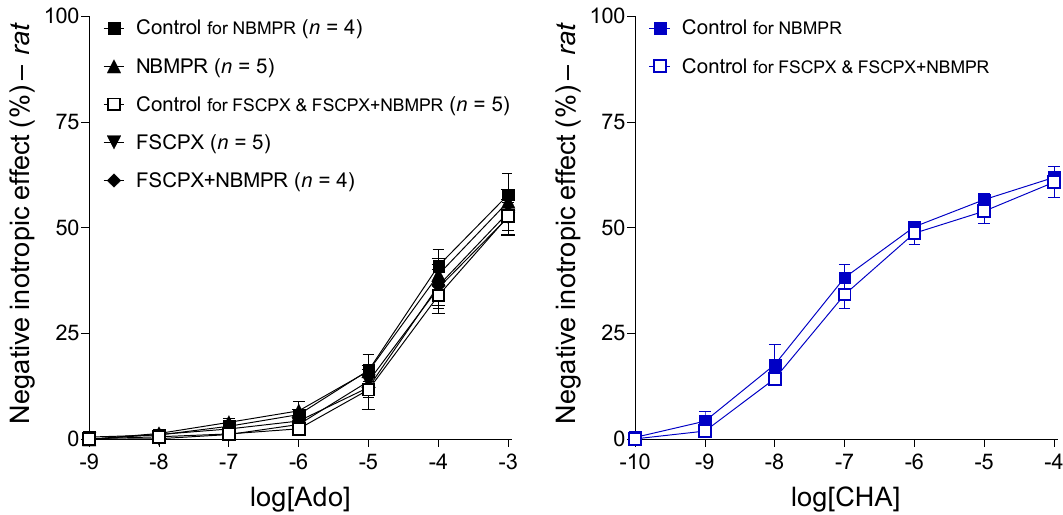
Figure 3. The direct negative inotropic effect of adenosine ( left panel ) and CHA ( right panel ) in the isolated rat left atrium, in the absence of any chemicals affecting the adenosinergic homeostasis. The left panel shows all groups that were handled uniformly until this stage of the investigation (the group names refer to subsequent in vitro treatments). The right panel presents the two control groups that underwent two in vitro treatments different in their duration. The x -axis denotes the common logarithm of the molar concentration of the given agonist (in the bathing medium), and the y -axis shows the effect (as a percentage decrease in the initial contractile force). The symbols indicate the responses to the agonists averaged within the groups (± SEM). The blue color used for the E/c curves in the right panel corresponds to the color code seen in Figure 4 (blue color refers to the absence of an FSCPX pretreatment). Ado: adenosine; CHA: N 6 -cyclohexyladenosine; E/c: concentration–effect.